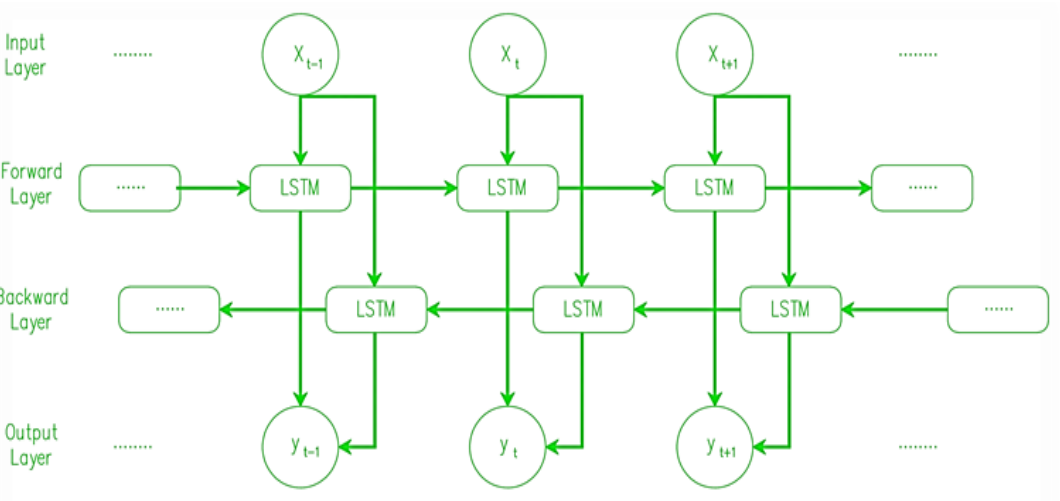
Figure 10. Basic architecture of the Bi-Directional LSTM model.